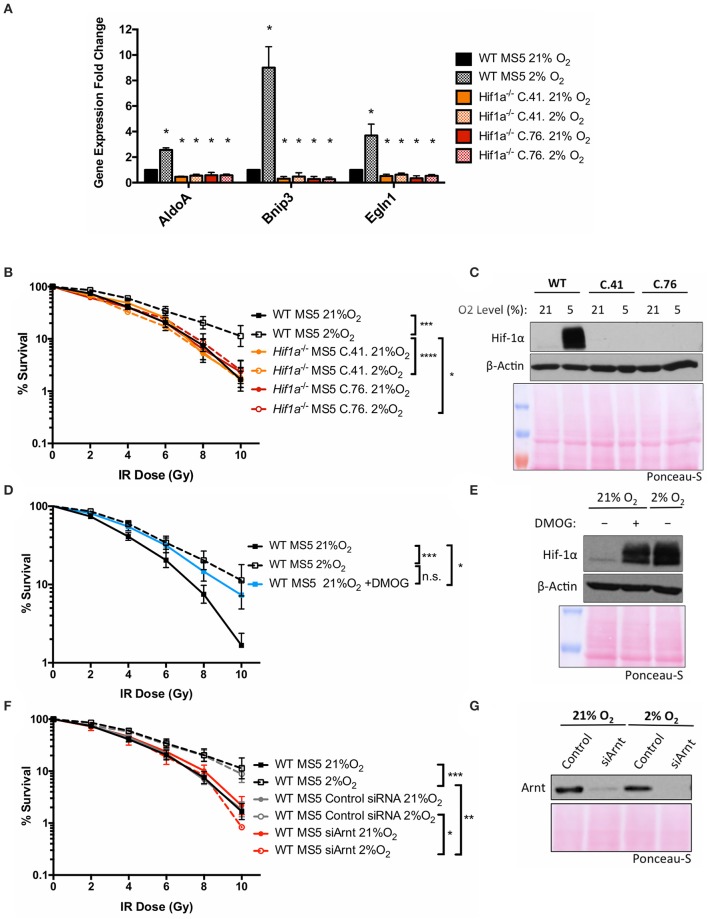
Both subunits of the transcription factor Hif-1 are required for the hypoxia-induced increase in MS5 radio-resistance. (A) Relative mRNA expression of the Hif-1α target genes AldoA, Bnip3, and Egln3, normalized against β-Actin and WT MS5 cultured in normoxia for mRNA relative expression quantification using the ΔΔCt method. *p < 0.05, paired t-tests, n = 3. Clonogenic survival assay of (B) WT and Hif1a−/− MS5 clones 41 and 76, (D) WT MS5 cells cultured in normoxia (21% O2), hypoxia (2% O2), or normoxia plus treatment with 500 μM DMOG for 48 h, and (F) untransfected, control and Arnt knock down WT MS5 cells. *p < 0.05, **p < 0.01, ***p < 0.001, ****p < 0.0001, two-way ANOVA, n = 6. Representative Hif-1α western blot showing (C) WT MS5 cells and Hif1a−/− MS5 clones 41 and 76 and (E) WT MS5 cells untreated or treated with 500 μM DMOG for 48 h. (G) Representative Arnt western blot of WT MS5 cells transfected with Control or siArnt siRNA.